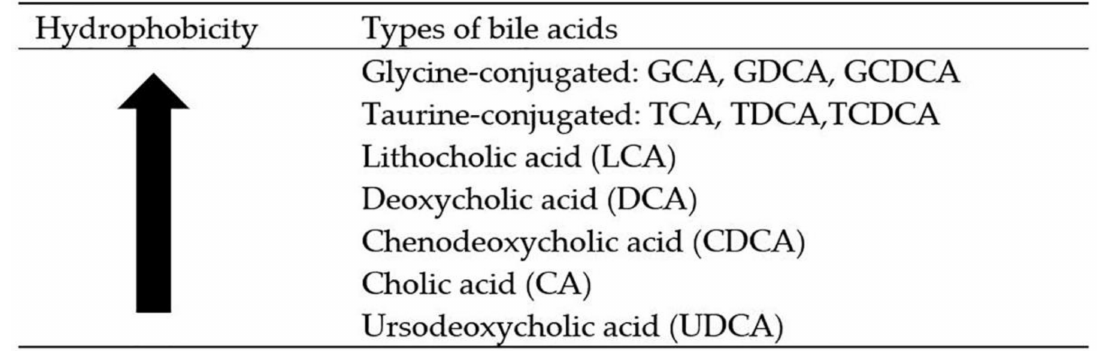
Figure 1. The hydrophobicity of bile acids decrease with increase in OH groups. (GCA, glycocholic acid; GDCA, glycodeoxycholic acid; GCDCA, glycochenodeoxycholic acid; TCA, taurocholic acid; TDCA, taurodeoxycholic acid; TCDCA, taurochenodeoxycholic